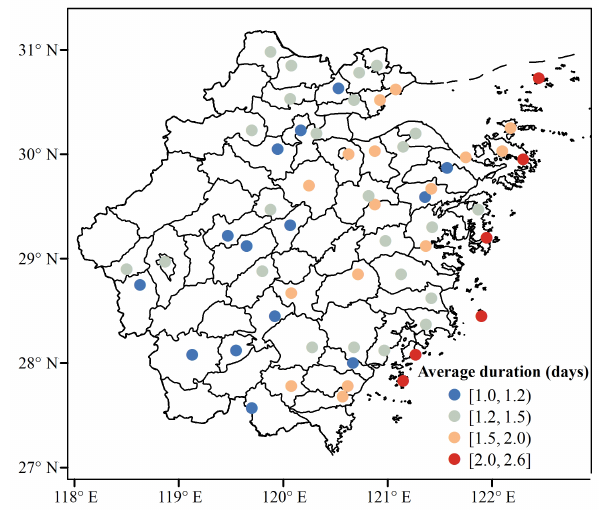
Figure 6. Average duration (days) of typhoon winds (over grade 6) at each station in Zhejiang Province from 1980 to